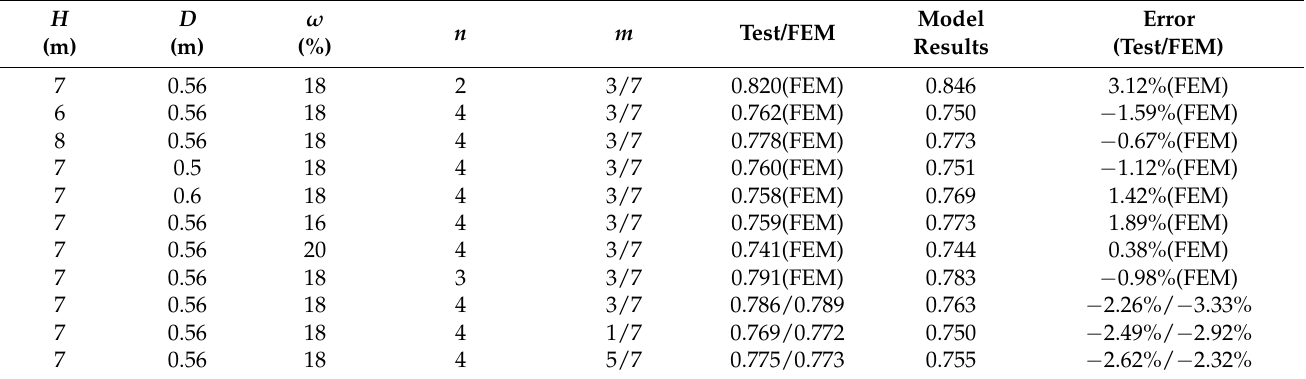
Table 5. Comparison between model results and test and numerical results at the